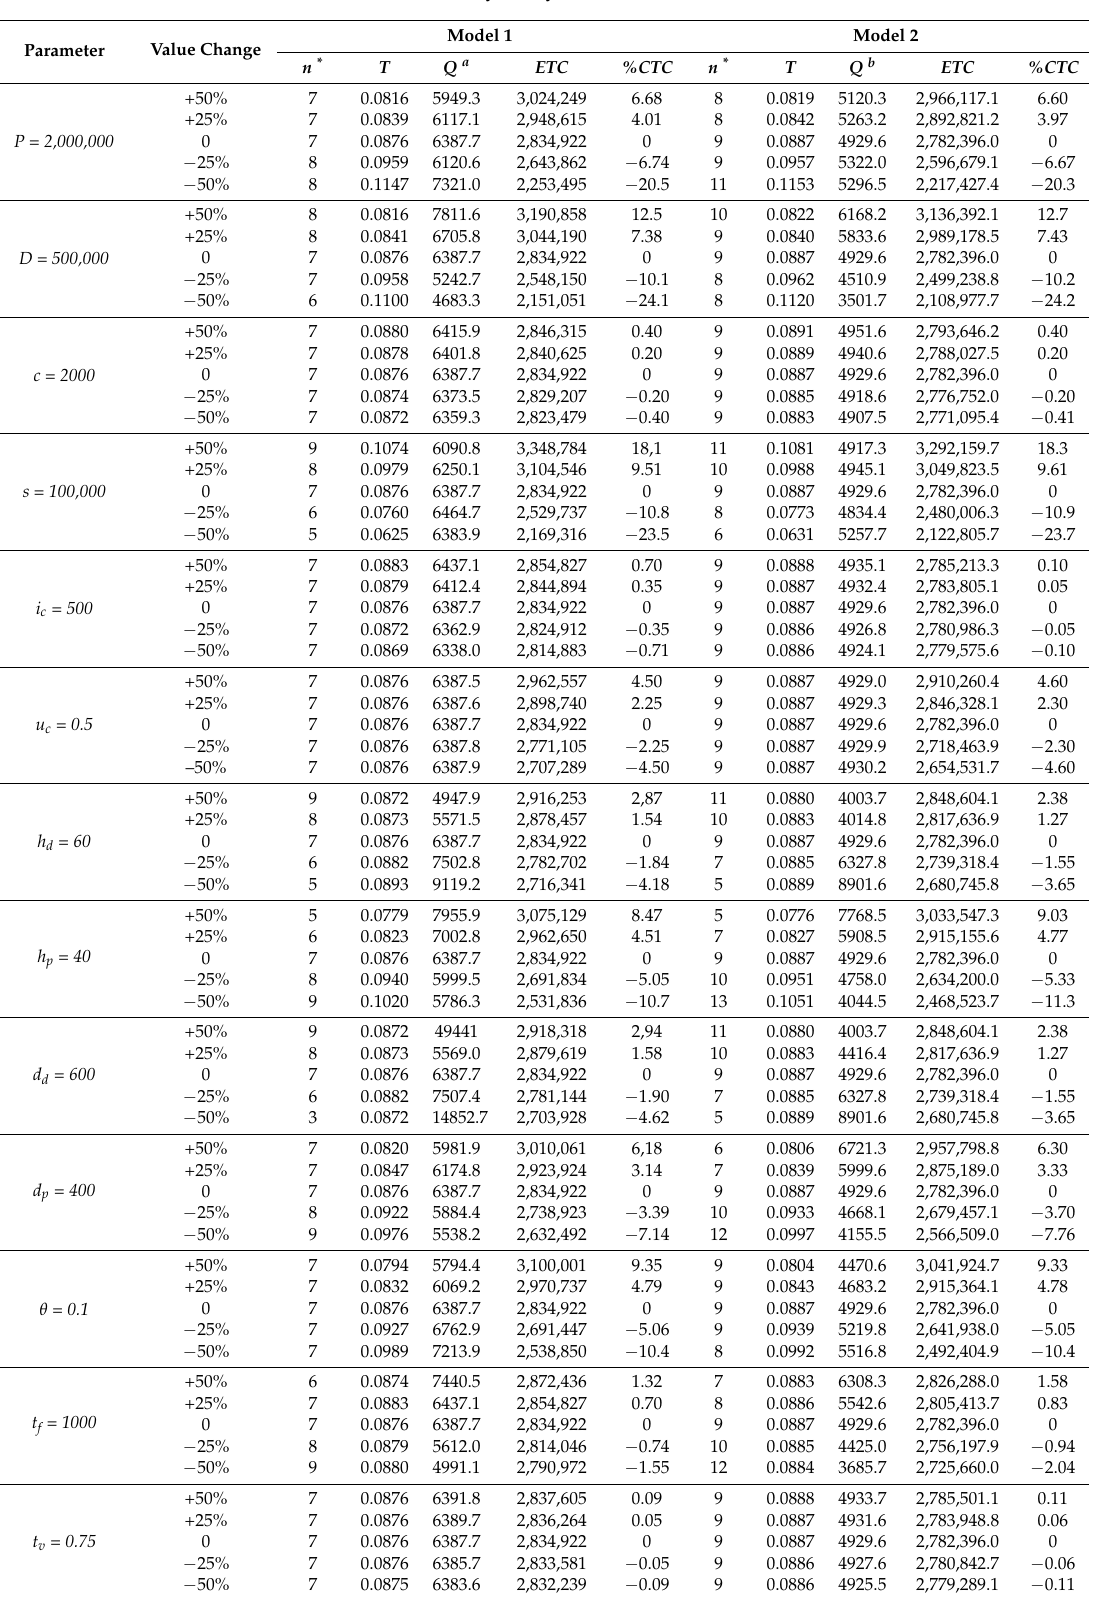
Table 7. Sensitivity analysis of the two